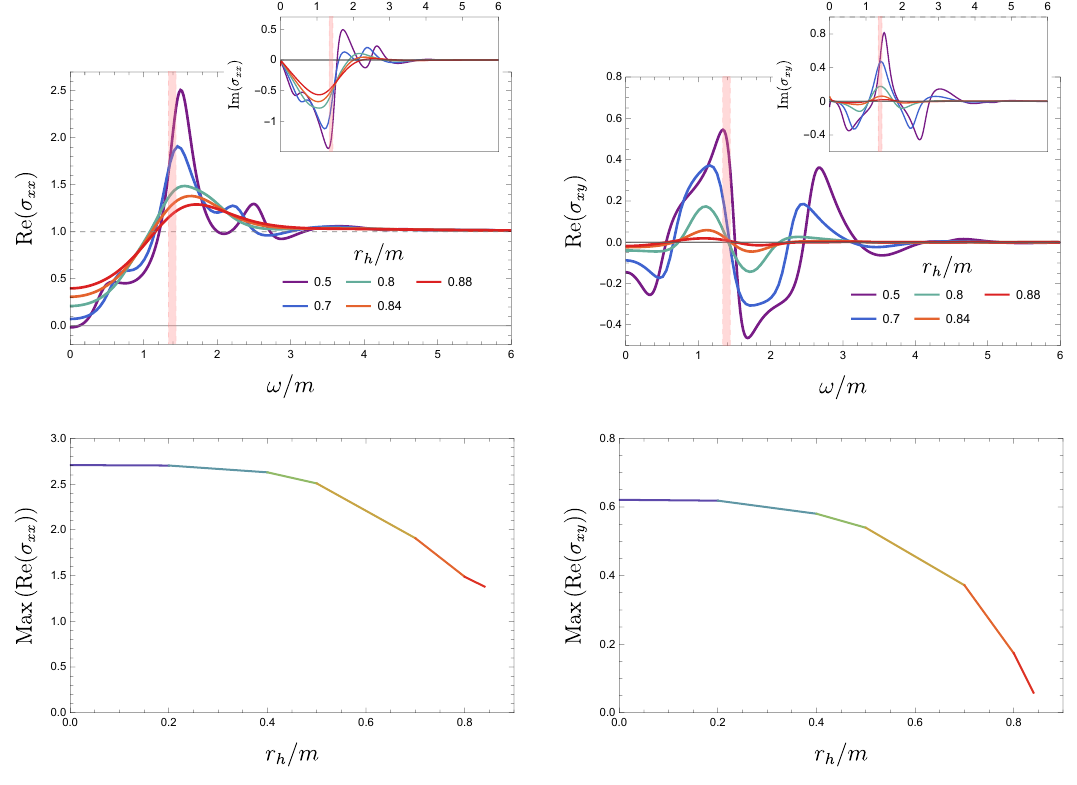
Figure 10 . Top : AC conductivities for four values of r h at their corresponding Ω c ( r h ) , for E/m 2 = 0 . 1 . The pink band marks the range where the four values of Ω c ( r h ) belong. The main peak is close to this region. Bottom : variation with the temperature of the maximum value of the real part of σ xx and σ xy for E/m 2 = 0 .